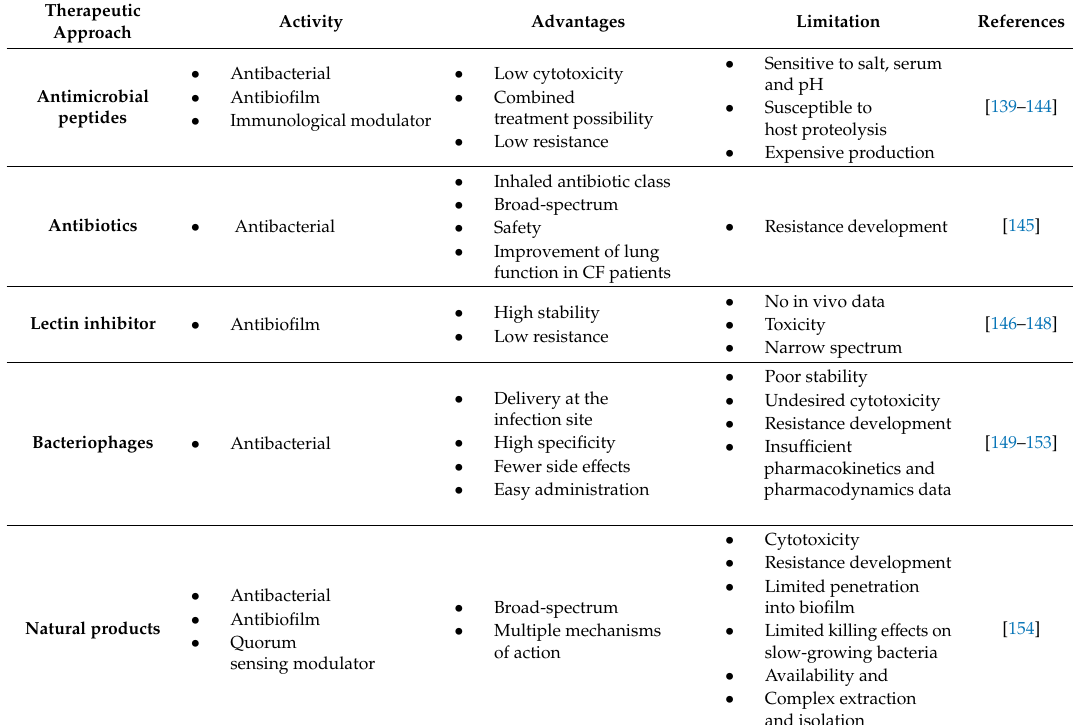
Table 1. Summary of therapeutic strategies against P. aeruginosa